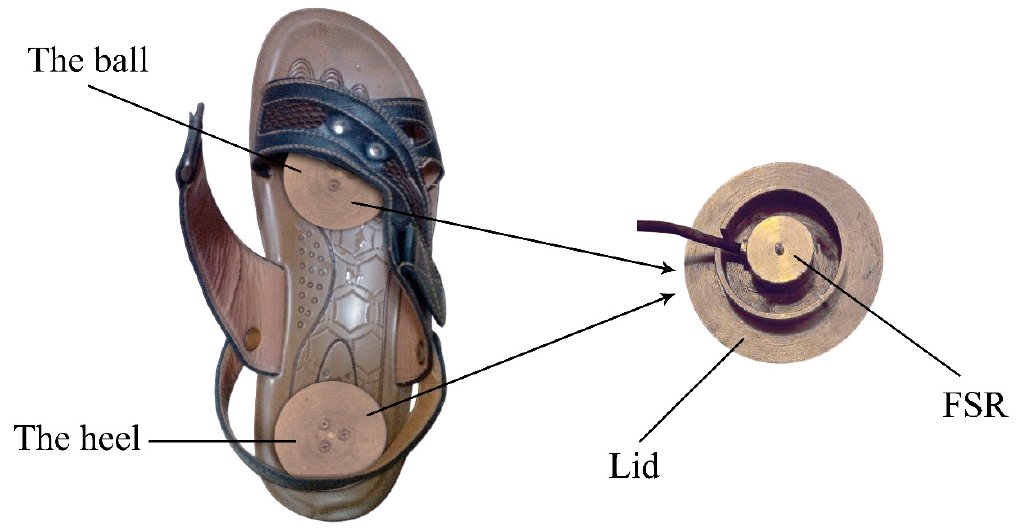
Figure 1. Two load cell mounted severally in the ball and heel, and a lid is used to enlarge the contact area.